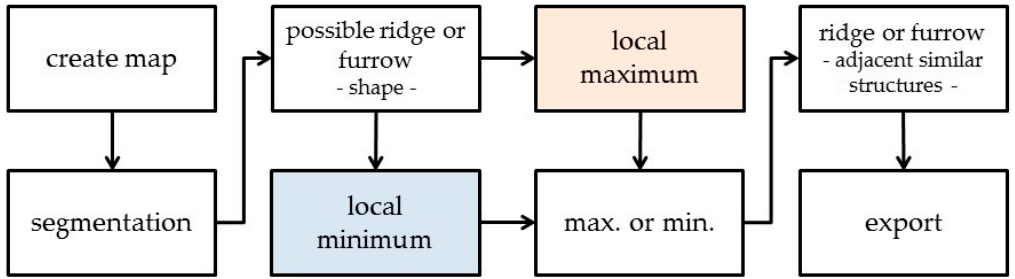
Figure 12. Overview of the workflow in eCognition for the detection of Ridge and Furrow areas. Table 5. Description of the class possible ridge or furrow .